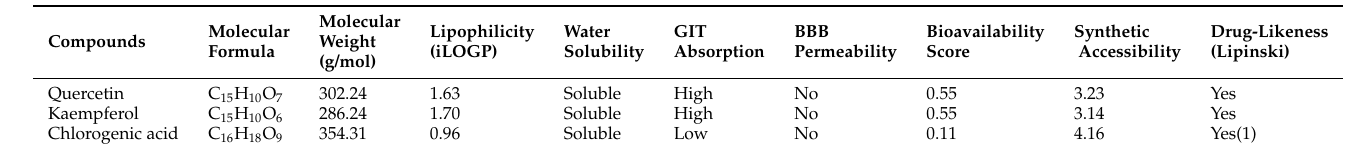
Table 3. Predicted ADME parameters, drug-likeness, pharmacokinetic, and physicochemical proper- ties of CP-leaf compounds using the SwissADME server.